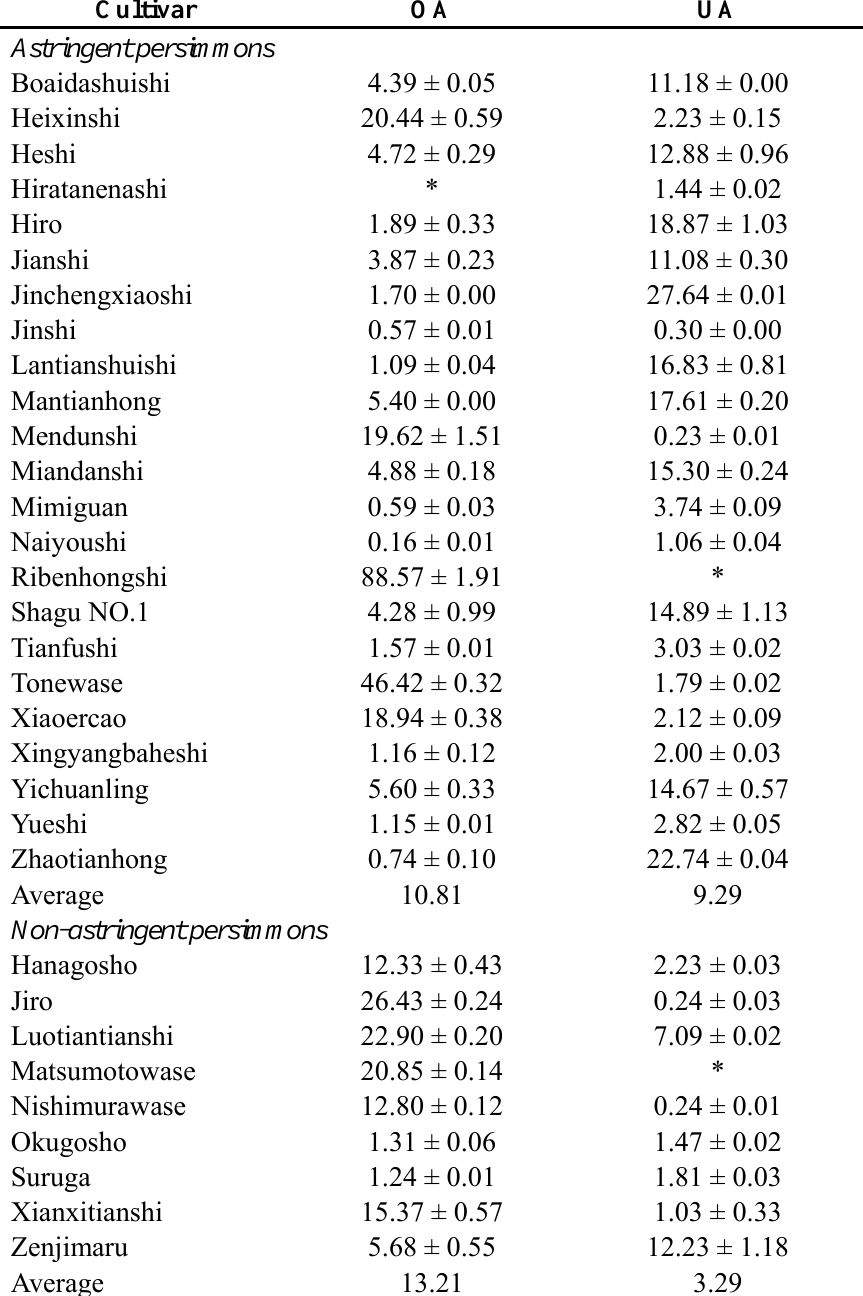
Table 2. OA and UA Content in the Flesh of Persimmon Fruits ( μ g/g